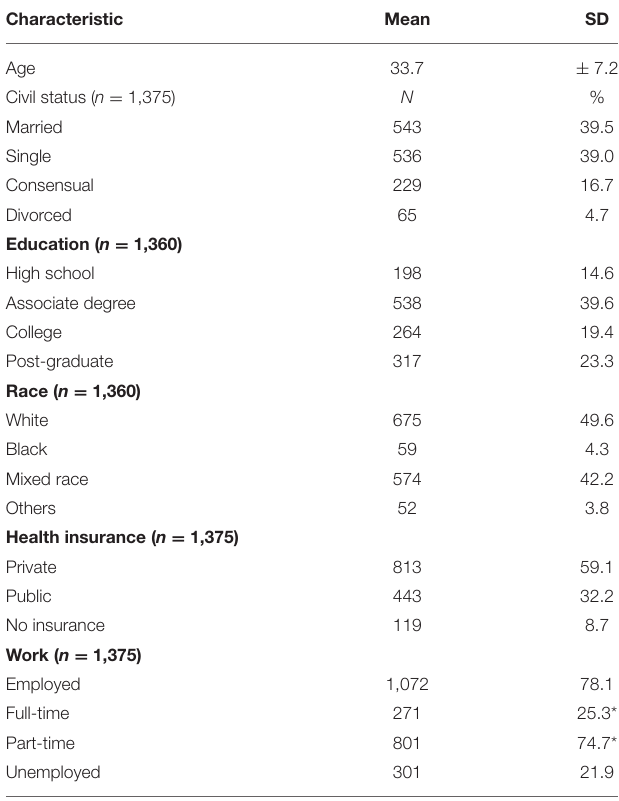
TABLE 1 | Sociodemographic characteristics of the women with endometriosis from Ibero-America.